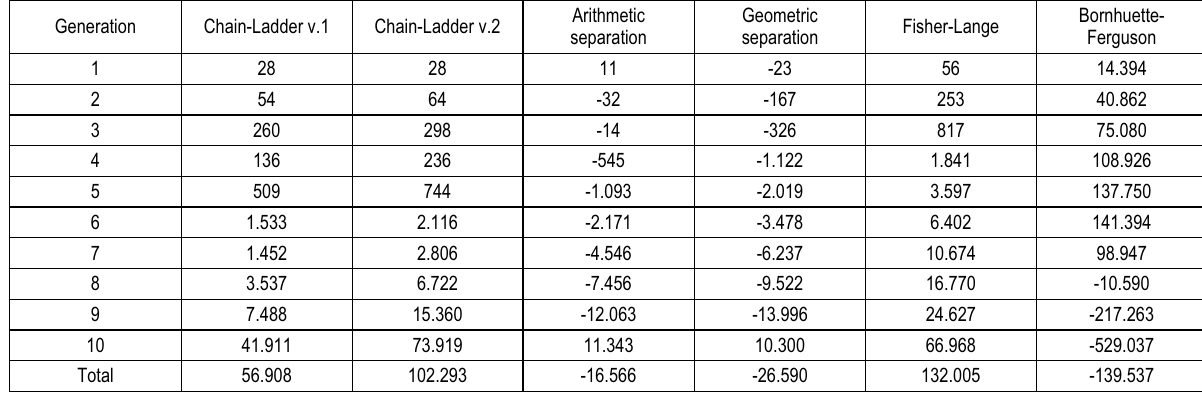
Table 14. Bias-Pentikainen-Rantala method